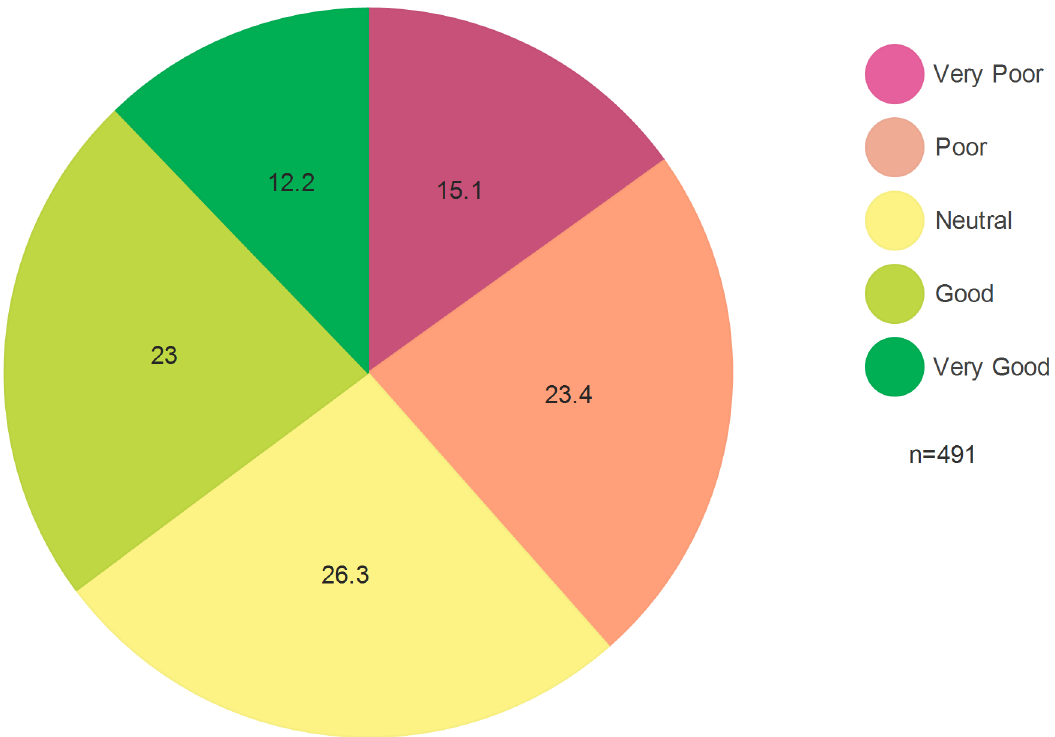
Fig 2. Perceived access to HIV/AIDS treatment and care services as rated by the participants